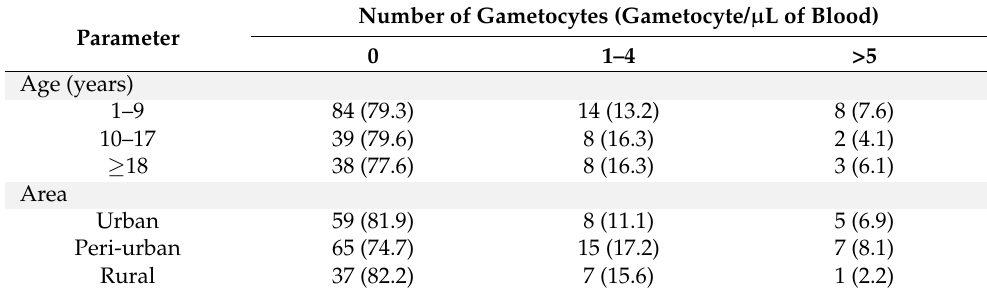
Table 4. Association between malaria and soil ‐ transmitted helminths.